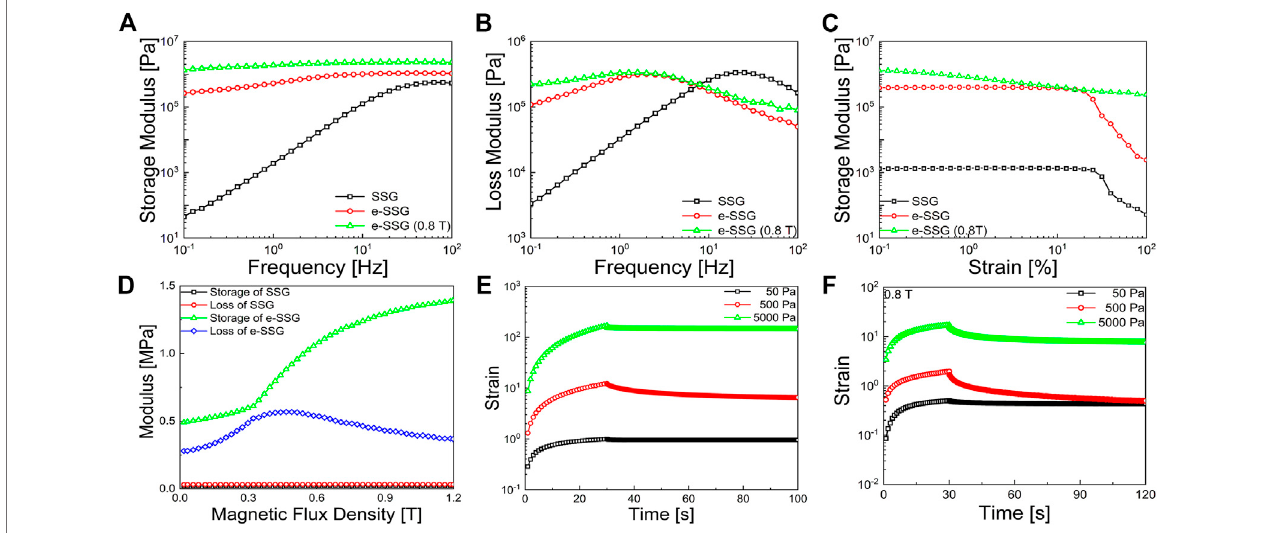
FIGURE 2 | The rheology behaviors of the SSG. (A,B) The shear stiffening behaviors ofSSG and e-SSG. (C) The storage modulus under different shear strain. (D) The magnetorheological effect of SSG and e-SSG. The creep and recovery behaviors of the e-SSG under different shear stress and with the absence (E) and presence (F) of the magnetic fi